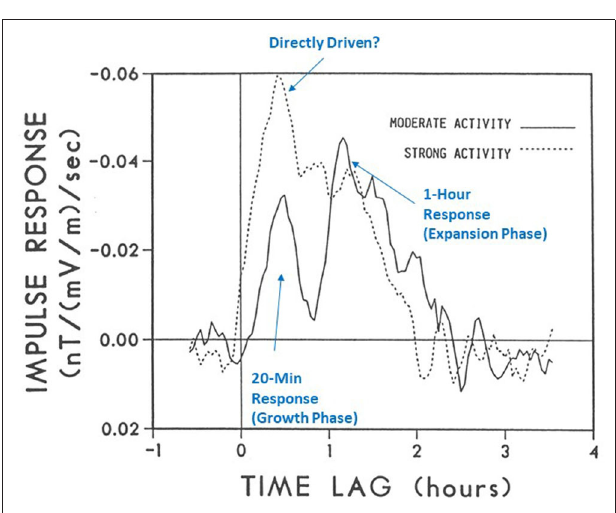
FIGURE 7 | A pair of linear prediction filters (or impulse response curves) showing the time-lagged response between the interplanetary electric field (VB S ) and the AL geomagnetic activity index. The linear prediction filters are chosen for a weak average activity interval and a strong activity period. An evolution from double-peaked (bimodal) filter to single-peaked filter suggests a non-linear dynamical behavior of magnetospheric activity (adapted from Bargatze et al.,